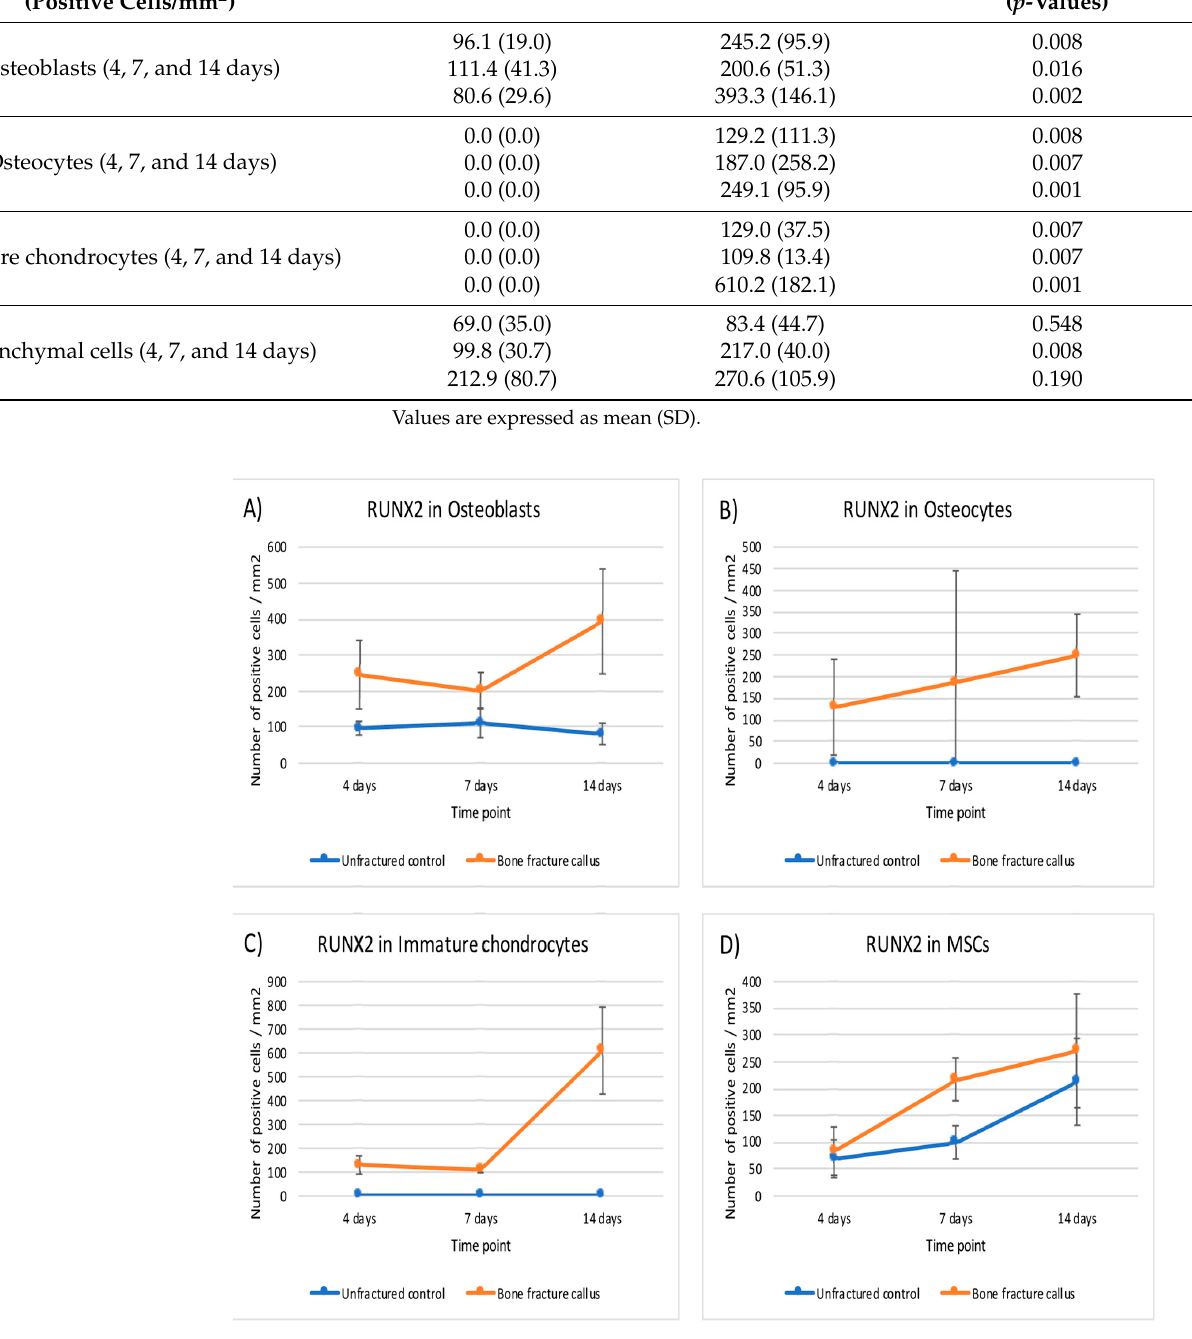
Figure 7. Graphical representation of the expression of RUNX2 in bone fracture callus (orange line) and unfractured control areas (blue line) over time in ( A ) osteoblasts, ( B ) osteocytes, ( C ) immature chondrocytes and ( D ) MSCs (mesenchymal stromal cells).